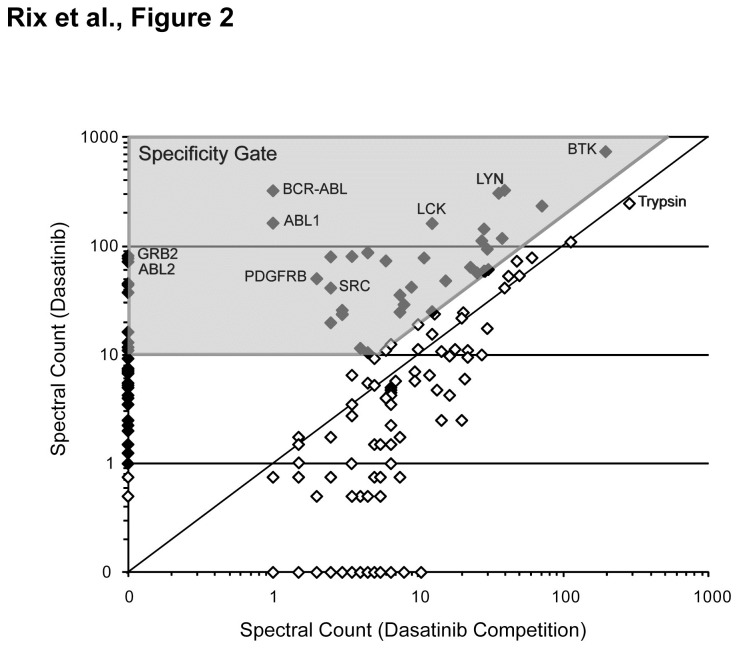
Graphical representation of binding specificity assessment.Using the example of dasatinib and BV-173 cells, the average spectral counts obtained from chemical proteomics were compared with the respective competition experiments in the presence of 20 µM free drug in a double-logarithmic plot. Specific ( ♦) and non-specific (◊) binders were identified by definition of a specificity gate (grey area) with a ratio threshold of 2 and a minimum average spectral count of 10. For proteins that were not identified in the competition experiment, the minimum average spectral count was lowered to 1.